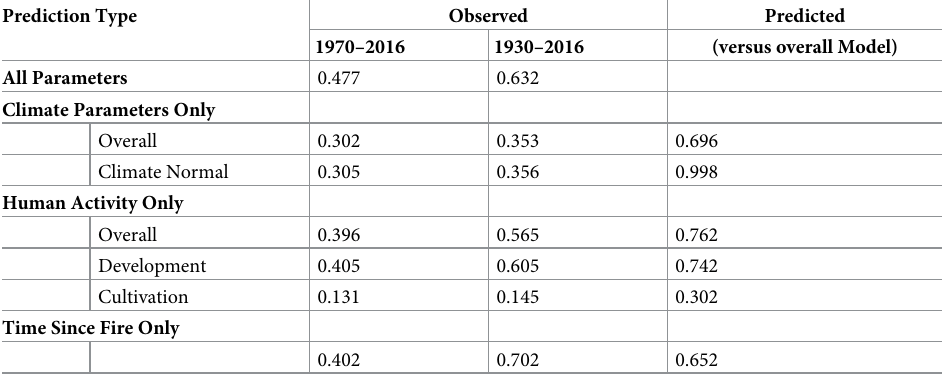
Table 4. Pearson correlation between observed 1970–2016 (and 1930–2016) fire probability and predicted fire probability from 1970–2016, as well as Pearson correlation among predictions of fire probability generated using a full model, using only local climate conditions, only local climate normals, human development (consisting of local housing density, distance to electrical infrastructure, and distance to roads), cultivation (consisting of % cul- tivated area within each pixel), and time since the most recent fire within each pixel.